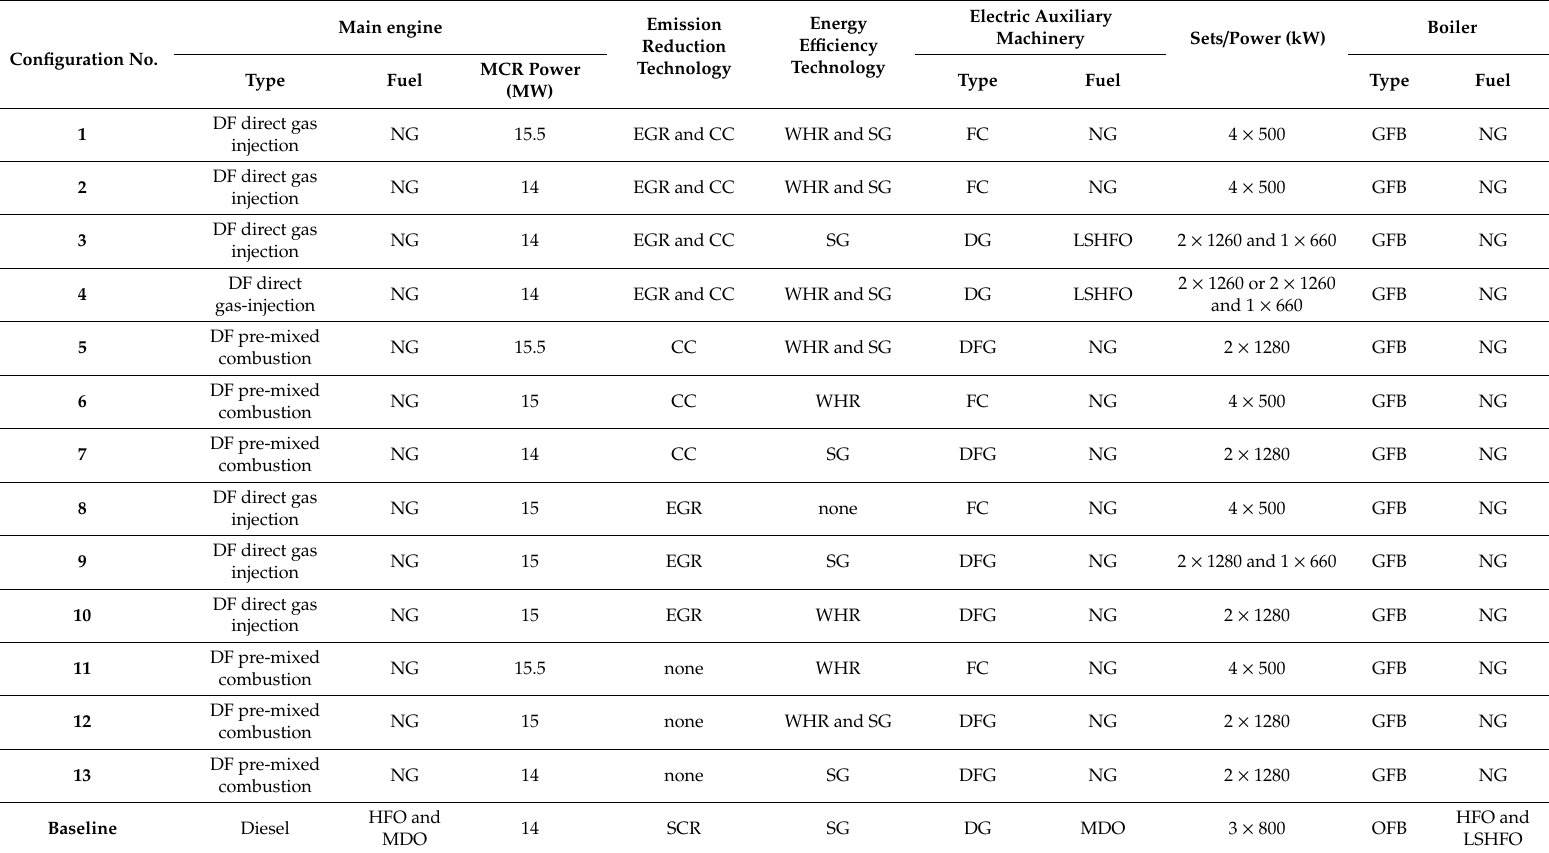
Table 9. Investigated power plant configurations for the Aframax